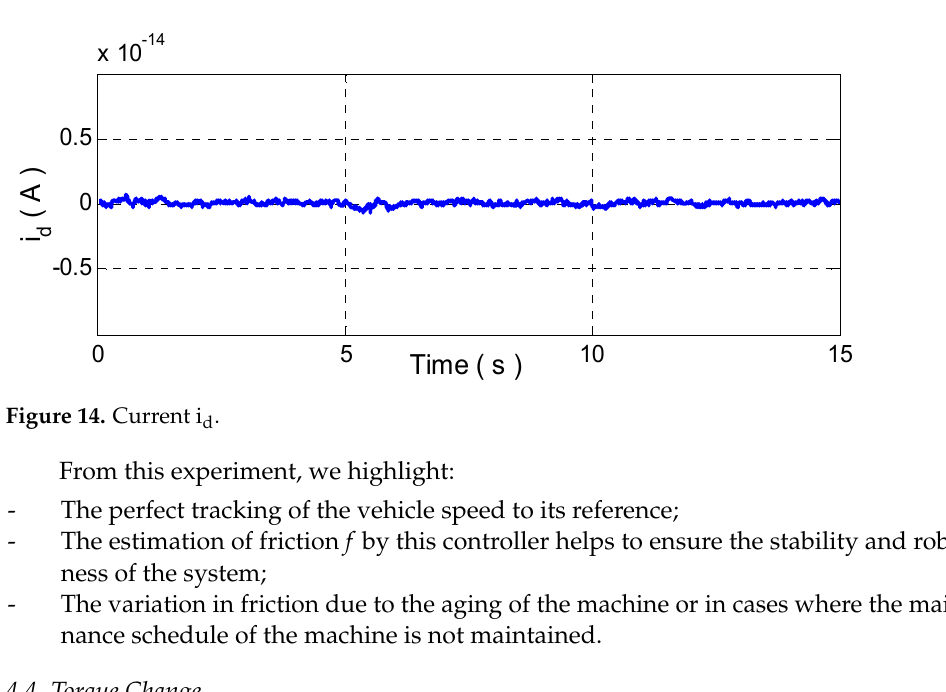
Figure 13. Current i q with zoom.